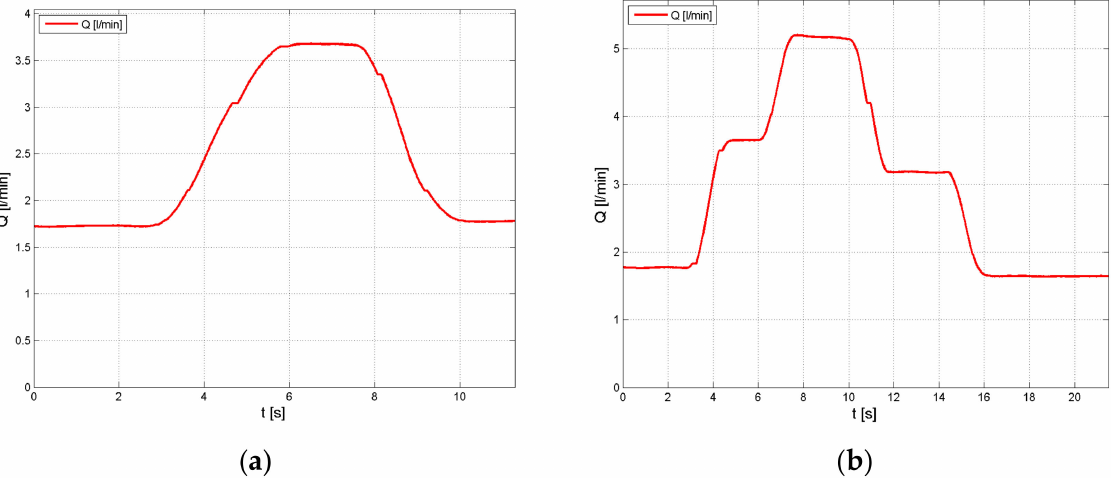
Figure 23. Flow rate: ( a ) Single speed ramp; ( b ) Double speed